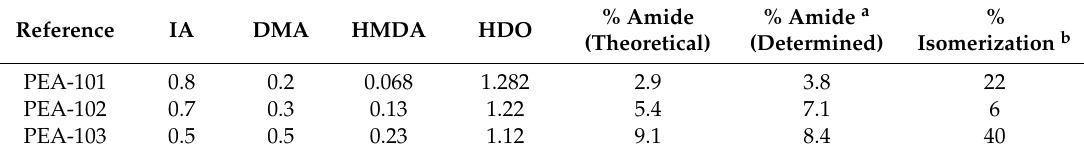
Table 2. Different compositions and amide content of the PEAs synthesized via the pseudo one-pot